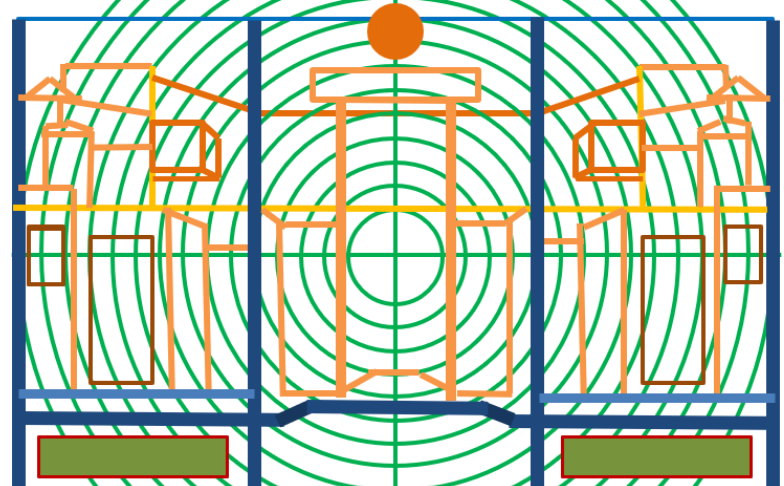
Figure 17. Final details added throughout. Source: the author.